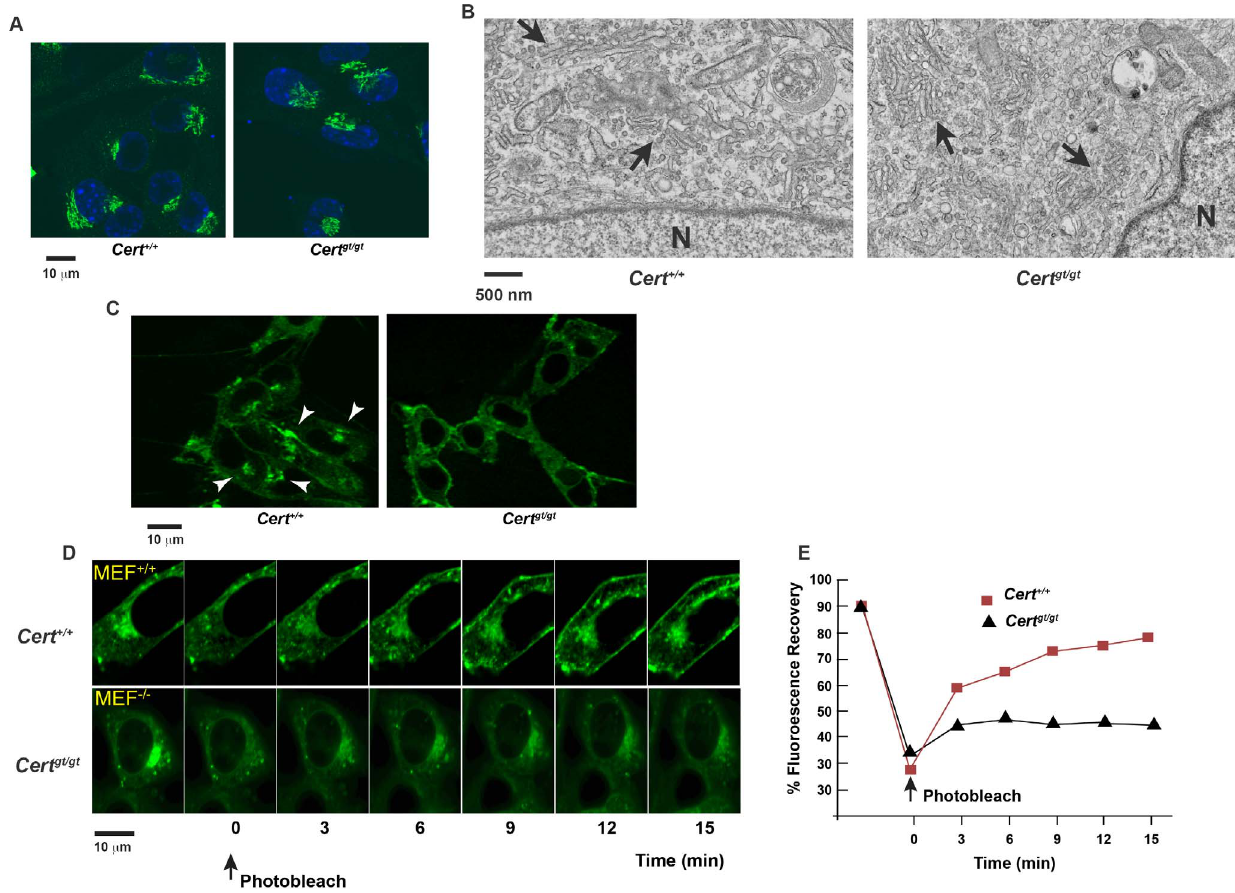
Figure 3. Altered Golgi dynamics in Cert gt/gt MEFs. (A) The Golgi architecture seems to be normal as evidenced by immunofluorescence staining using a Golgi marker (GM130) and (B) The ultrastructure of Golgi seems apparently normal although we see a slightly more fragmented pattern of Golgi compared to the wild type. N- denotes the nucleus and the arrows indicated the Golgi cisternae. (C) The MEFs were incubated with DMB-C5-Cer as described under materials and methods. While perinuclear concentration of the ceramide is clearly visible in Cert + / + the Cert gt/gt show a diffuse staining indicating a lack of transport of ceramide from the ER to the Golgi complex. (D) Recycling of cargo protein cholera toxin B (CTxB, associated with lipid rafts) between the plasma membrane and the Golgi complex is impaired in the mutant MEFs. (E) Quantification of the extent of recovery after photobleaching.